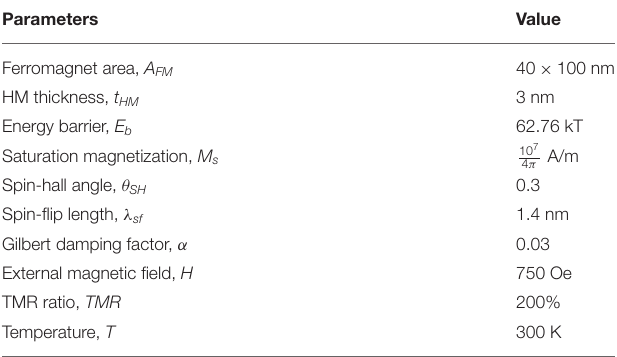
TABLE 1 | MTJ device simulation